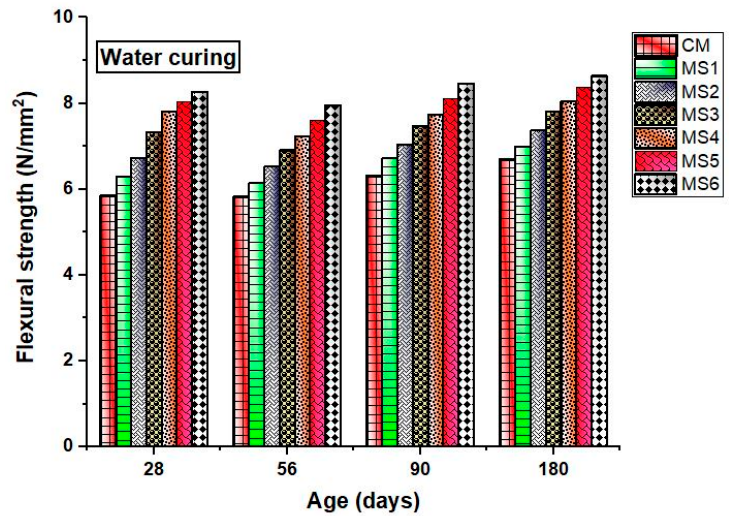
Figure 7. Flexural strength of the concrete mixes in water curing at various ages.